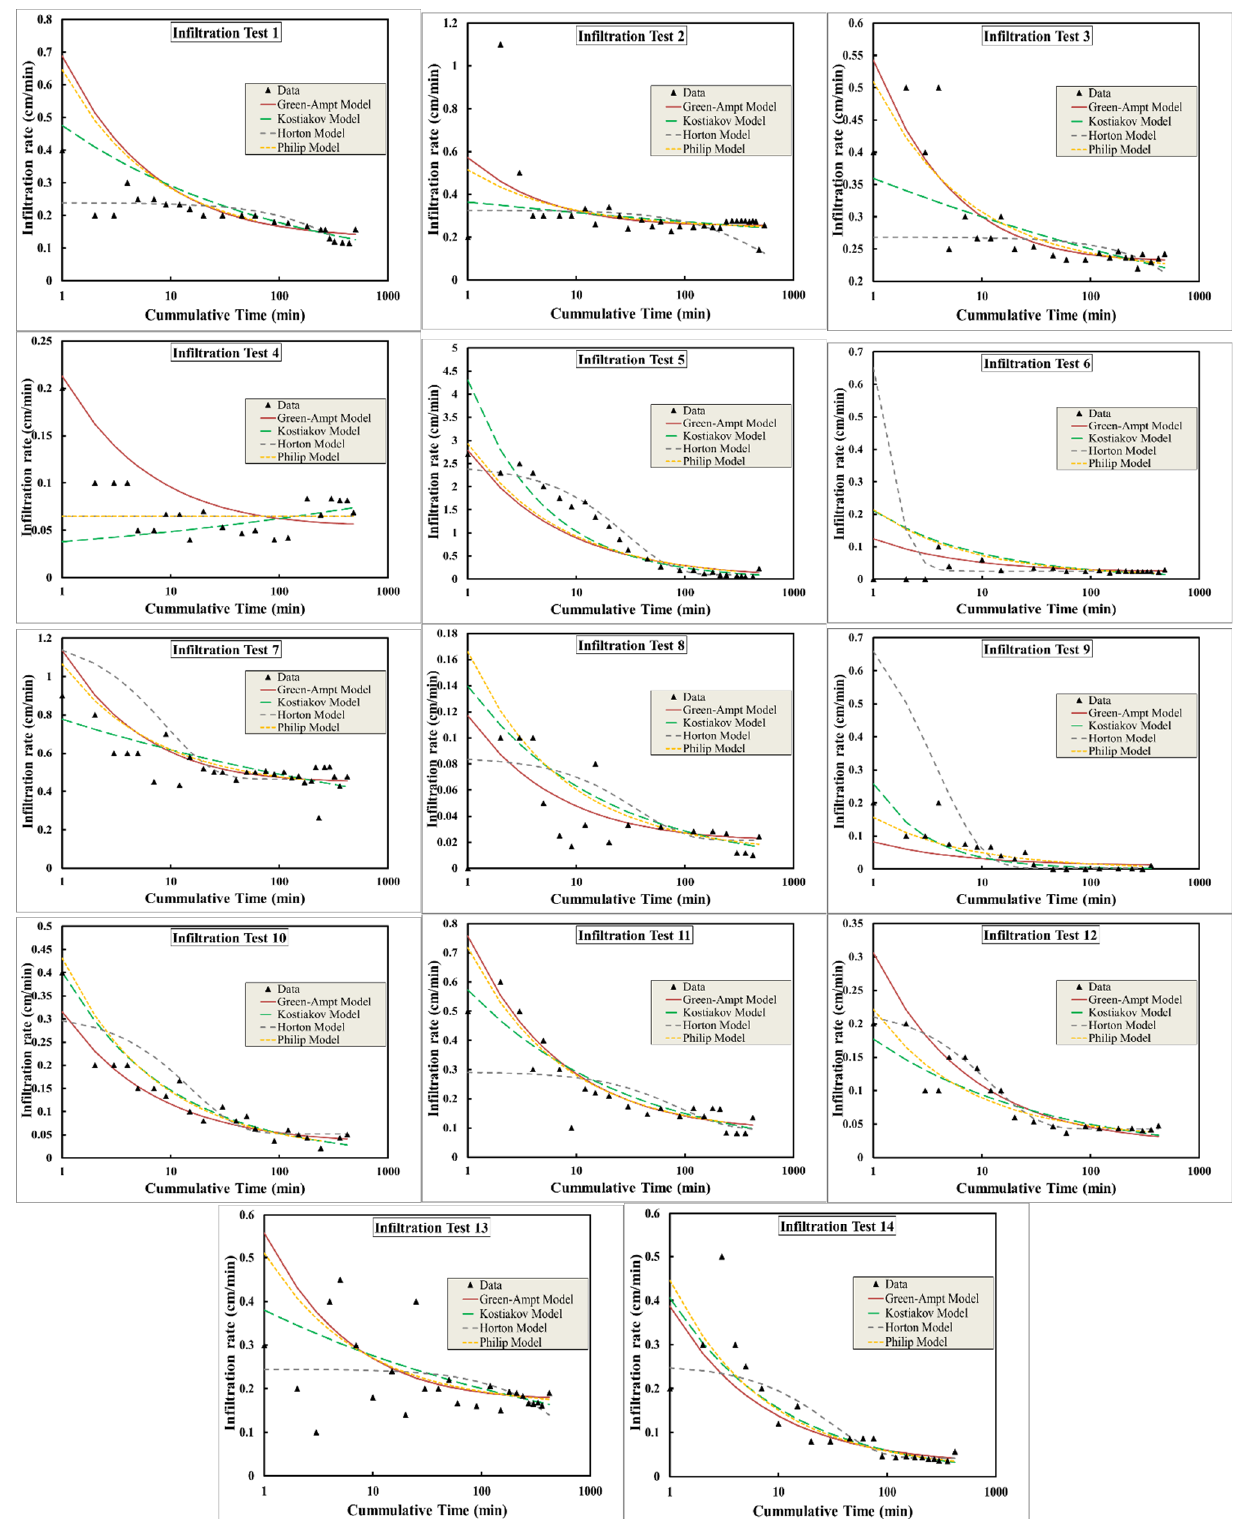
Figure 8. Field ‐ measured cumulative infiltration depth versus modeled cumulative infiltration depth with the various models.